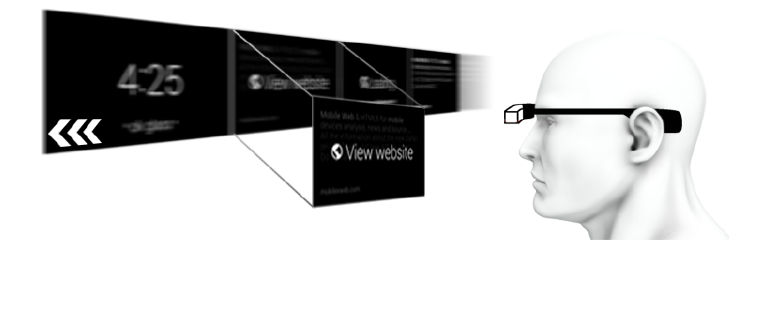
Figure 8. In the EyeGrip interaction technique, the scrolling content on the Head-Mounted Display stops automatically when a particular object attracts more visual attention